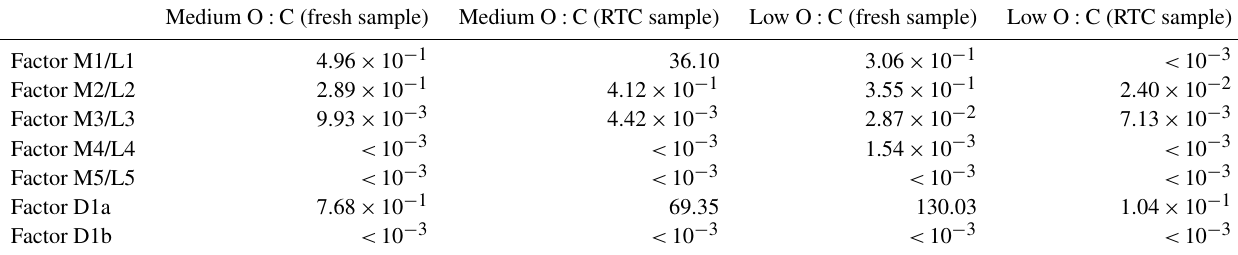
Table 2. The best-fit C ∗ values for medium- and low-O : C high-RH experiments, when C ∗ values of PMF factors were optimized with respect to the measured isothermal evaporation. C ∗ values were optimized by assuming that the FIGAERO–CIMS sample represents particle composition at the mean sample evaporation time for the fresh sample and the minimum sample evaporation time for the RTC sample. The C ∗ values are rounded to two significant digits and are in units µgm − 3 . C ∗ values below 10 − 3 µgm − 3 are not reported explicitly since the evapogram-fitting method is not sensitive to these values.